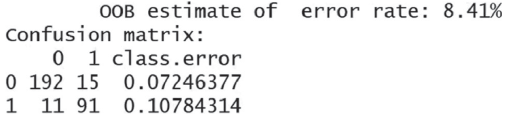
Figure 3: Results of R code for random